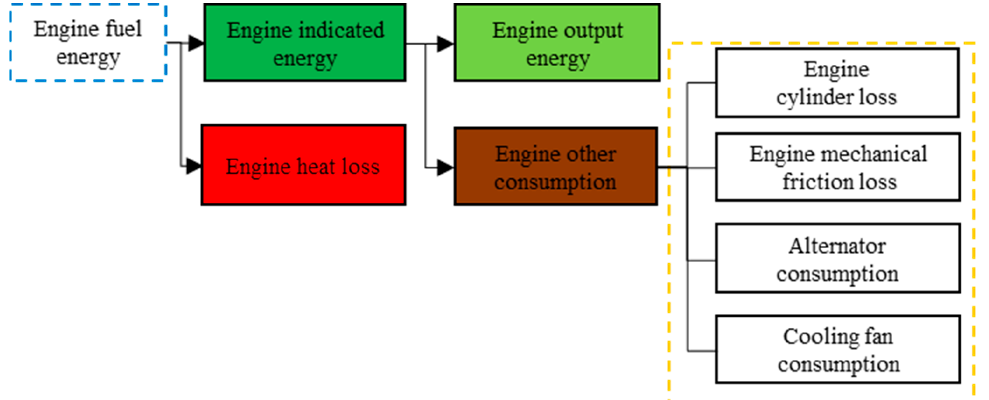
Bucket Cylinder Swing Motor Figure 1. Excavator work system. ( a ) ( e ) Figure 2. Operation stages of excavator. ( a ) Dig preparation; ( b ) digging; ( c ) lifting; ( d ) unloading; ( e ) swinging. 2.1. Engine Theoretical Energy Flow The engine’s energy transfer process includes heat loss, cylinder loss, mechanical fric- tion loss, generator consumption, etc. The remaining output energy is transferred to the